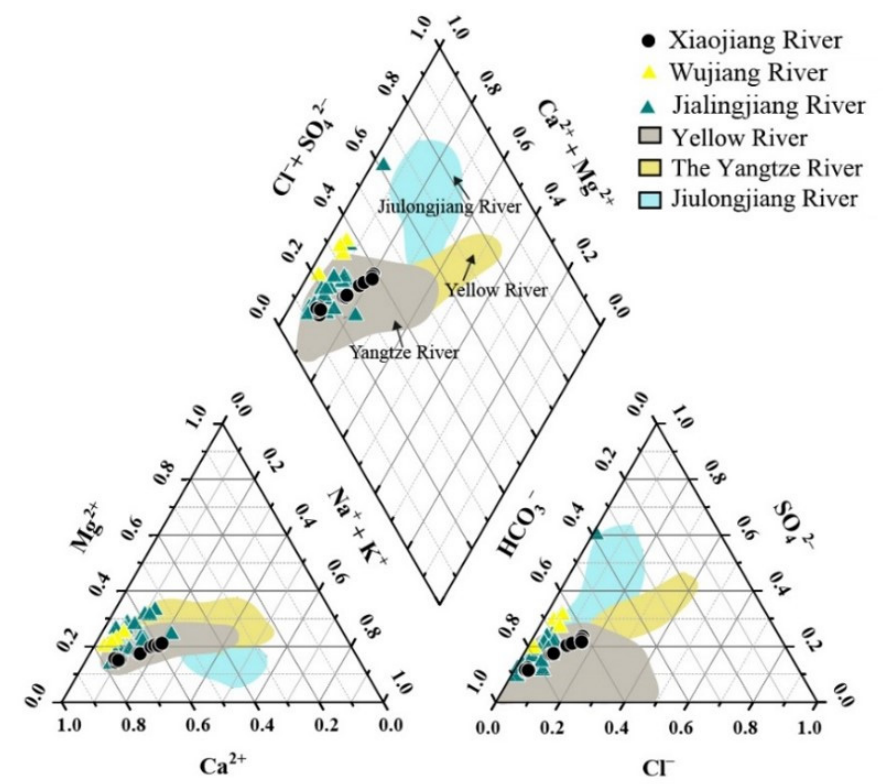
Figure 2. Piper’s graph of Xiaojiang River. The data of Wujiang River [53], Jialingjiang River [33], Yangtze River [32], Yellow River [55], and Jiulongjiang River [54] in the figure are surface water data during the wet season reported by previous studies.